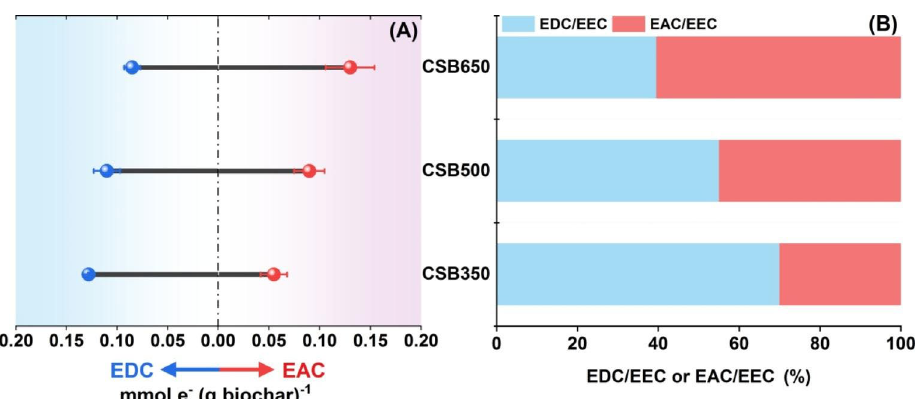
Fig. 10 Electron donating capacities (EDCs), electron accepting capacities (EACs) (A) of crawfish shell biochar (CSB) pyrolyzed at 350 ° C (CSB350), 500 ° C (CSB500), and 650 ° C (CSB650); the relative proportions of EAC and EDC values to the total electron exchange capacities (EEC, EEC = EDC + EAC) (B). The EAC and EDC values are presented as the average ± standard deviation from triplicate analyses. The cor - responding oxidative/reductive current responses to increasing amounts of biochar using mediated electrochemical analyses are provided in the Supplementary Material (Fig.